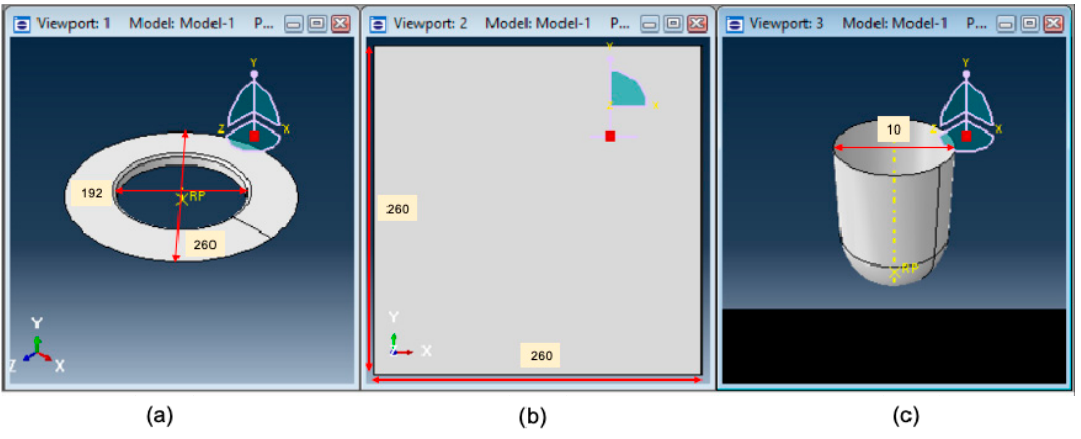
Figure 3. Parts used in ABAQUS with dimensions (All dimensions are in mm): ( a ) Tool holder; ( b ) Sheet; ( c ) Forming tool.